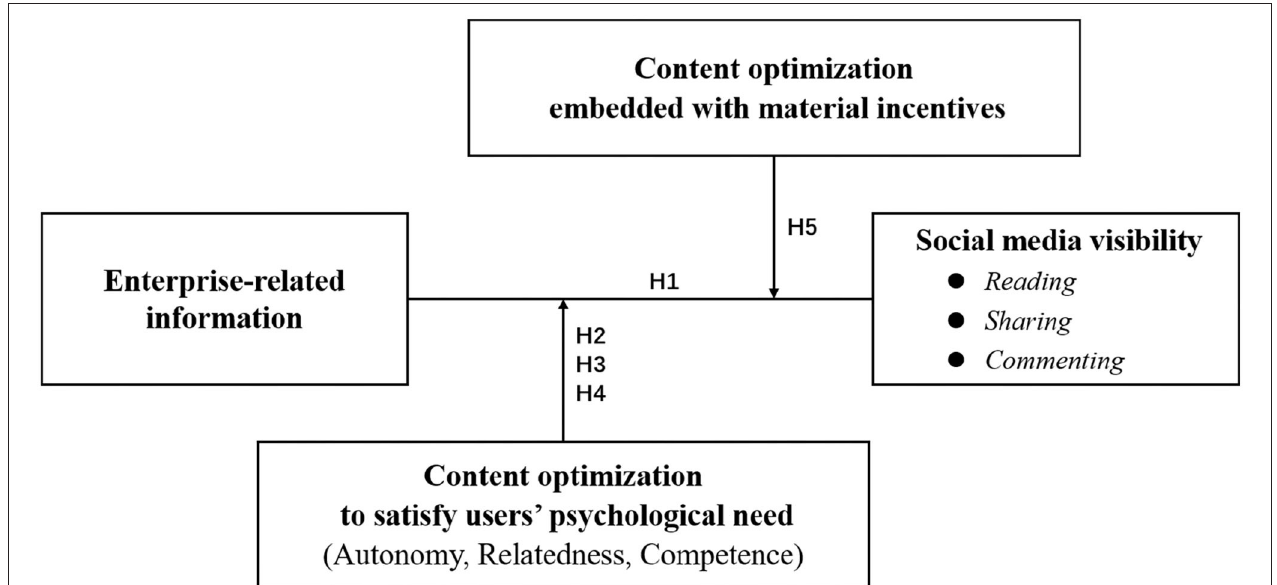
FIGURE 1 | The analytical